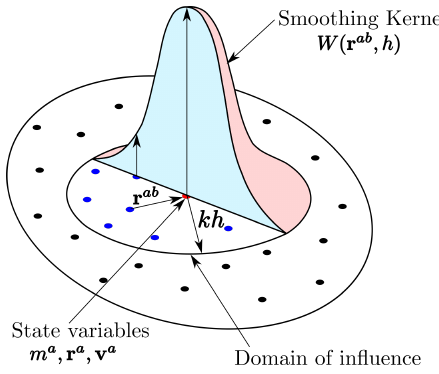
Figure 1. A schematic of a smoothing kernel function. Smoothing kernel function provides weighted contribution of neighbouring particles during the calculation of property at a